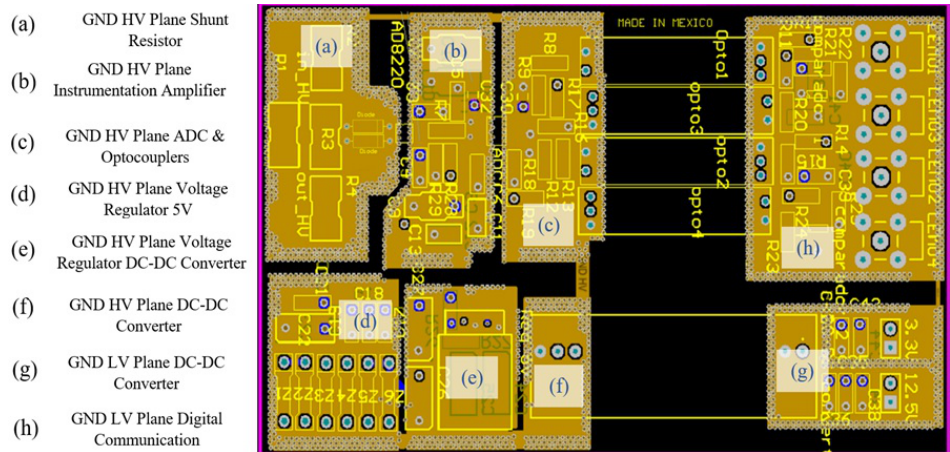
Figure 3. Distribution of the ground planes. The 6 planes ( a – f ) to the left of the Printed Circuit Board (PCB) are connected to the high-voltage ground and the planes ( g , h ) to the right of the PCB are connected to the low-voltage